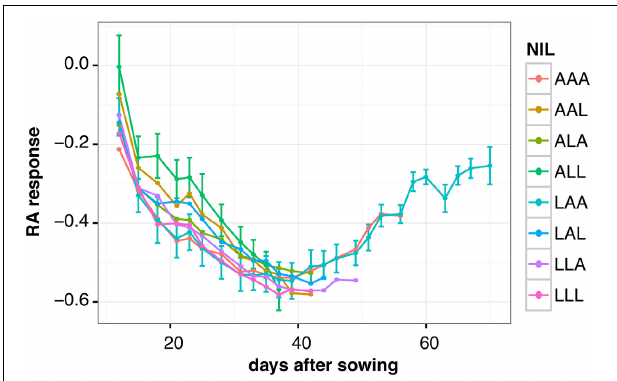
FIGURE 4 | Relative response of rosette area (RA) to water deficit in NILs over time. The NILs are named according to their allelic combination at QTL3, QTL5.1, and QTL5.2, where the An-1 and L er alleles are abbreviated by “A” and “L,” respectively. Average responses for 3 to 12 plants per line and time point are shown. Error bars indicate the standard error of the mean. For the sake of clarity, error bars are only shown for the two NILs flowering the earliest (ALL) and the latest (LAA),